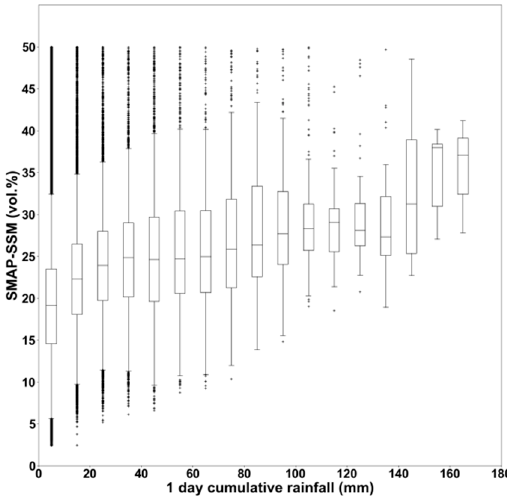
Figure 8. Soil Moisture Active Passive (SMAP)-SSM distribution as a function of one day of cumulative precipitation (revisit time of SMAP-SSM = one day).